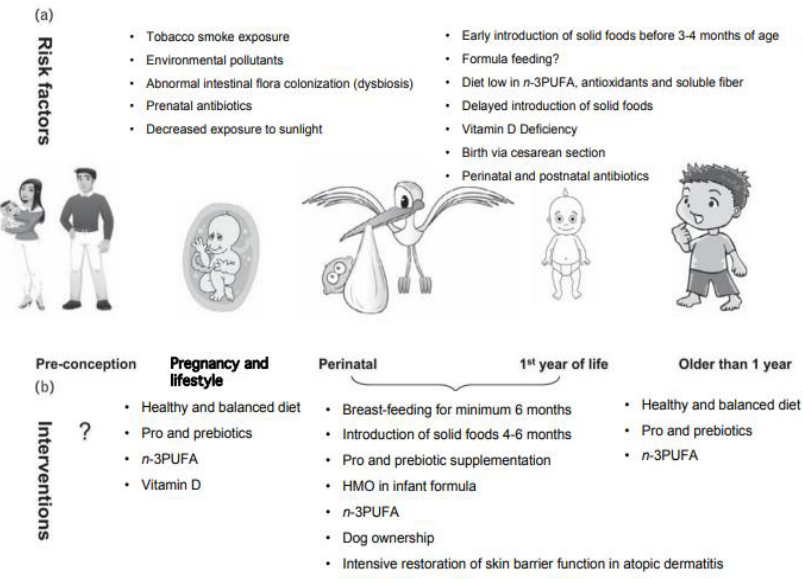
Figure 2. Other directions currently being investigated for food allergy prevention; ( a ) risk factors; ( b ) interventions. Modified with permission from Prescott and Nowak-W˛egrzyn [45]. Legend: n-3PUFA: n-3 Polyunsaturated Fatty Acids, which can include eicosapentaenoic acid (EPA) and docosahexaenoic acid (DHA) can provide multiple health benefits including anti-inflammatory effects [46]. HMO: Human milk oligosaccharides, a naturally present constituent of human milk